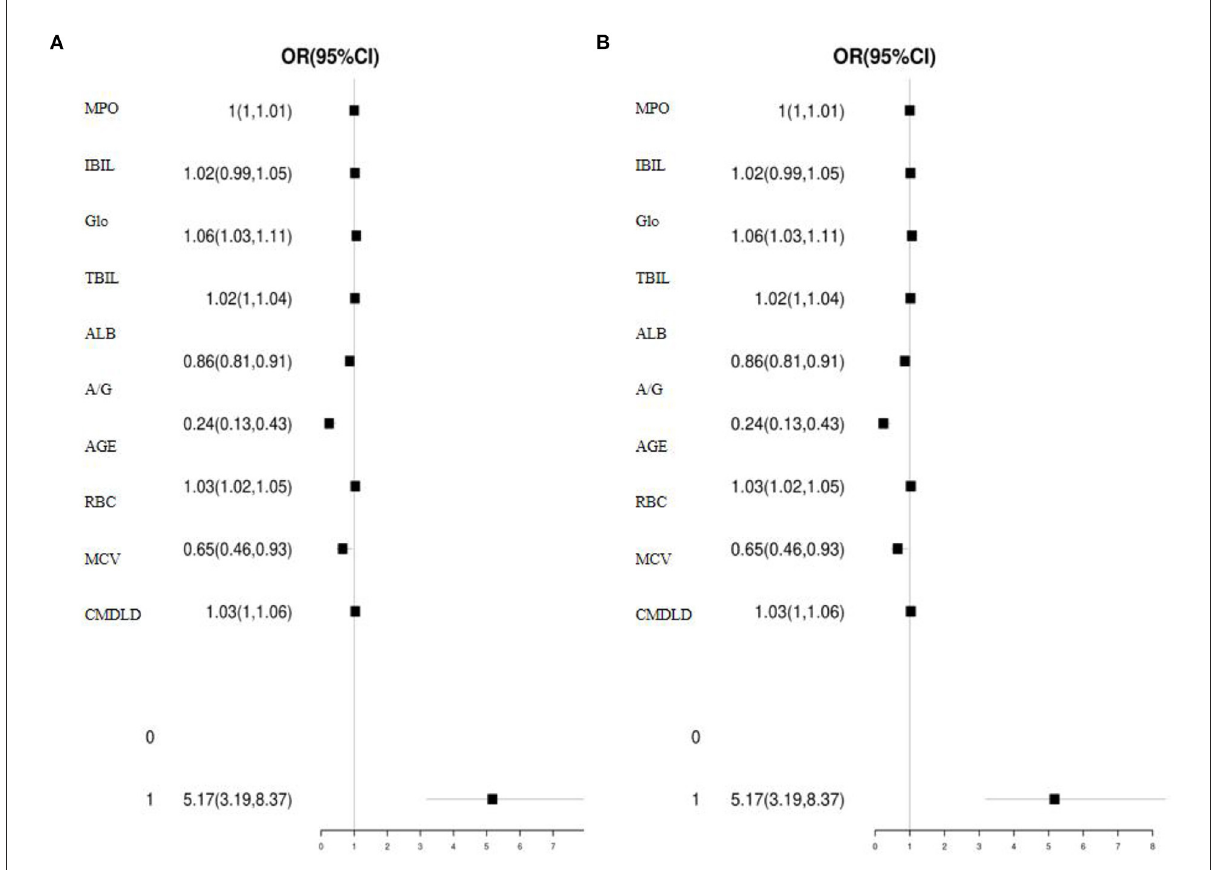
FIGURE2 (A,B) Univariate and multifactorial analysis of forest plots for the occurrence of nodular thyroid disease in coal